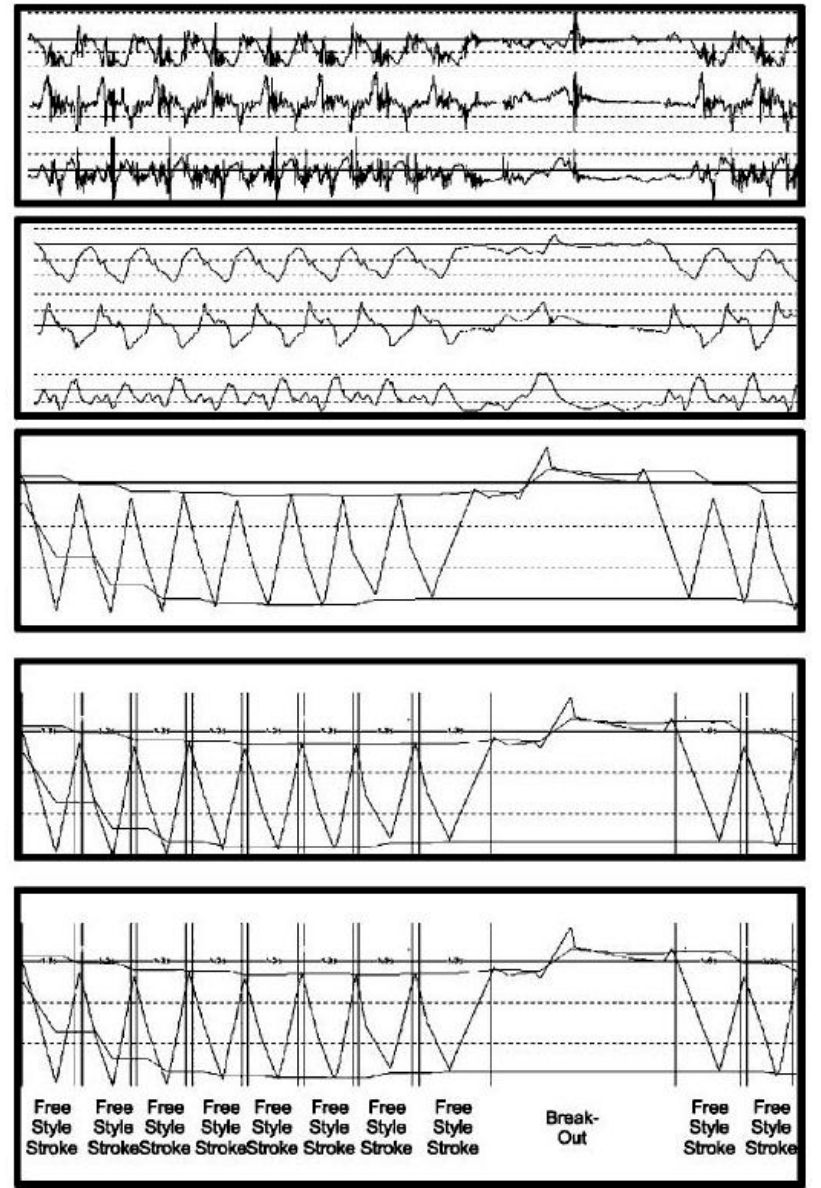
Figure 12. The process of determining stroke type from a wrist worn tri-axial accelerometer device: ( a ) raw acceleration signal; ( b ) low-pass filter with a cut-off of 1 Hz; ( c ) peak detection algorithm used to isolate maxima and minima; ( d ) individual strokes are identified; ( e ) recognition models applied to determine stoke type. Adapted from Anthony and Chalfant [38].